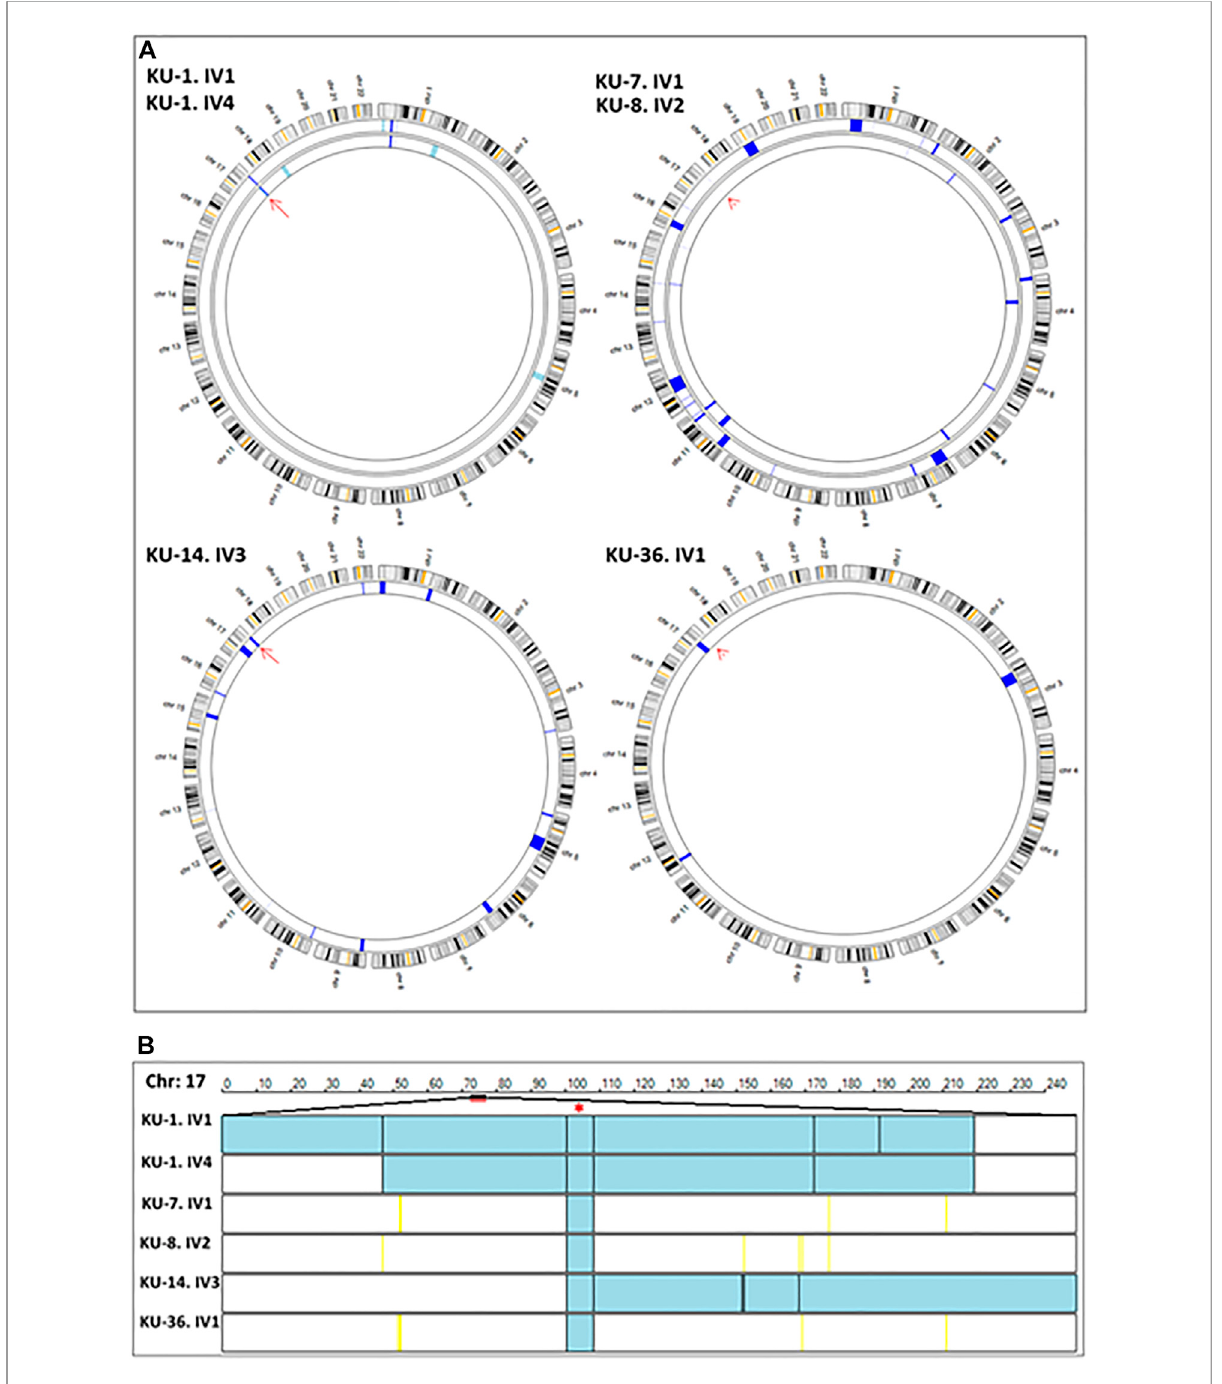
FIGURE 2 Linkage analyses using exome data. (A) summarizes the linkage analysis using AgileMultiIdeogram software and presented in such a way that each ideogram shows the overall linkage for the patients belonging to the same family and each lane accounts for one patient. The density of IBD is represented by the bulk of navy-blue bars for the shared regions of homozygosity (autozygous intervals). The light blue bars specify the unshared ROH regions in multiplex families. In singleton families, having one affected individual, all the detected ROH are displayed as navy blue bars, since there is no shared ROH to be prioritized by the software as seen for families KU-14 and KU-36. Linkage results show the two affected siblings belonging to the KU-1 family have an exclusive autozygous interval across the DNAI2 locus highlighted by a red arrow. Linkage analysis was performed for the two patients from families KU-7 and KU-8 together since they are distantly relatives and the results show a minute IBD interval across the gene locus that indicated by the red arrowhead. The same results were seen for KU-36, although this patient has another signi fi cant ROH interval upstream of the DNAI2 locus suggesting that the founder variant in DNAI2 has a very high penetrance. (B) shows the linkage scan for the six